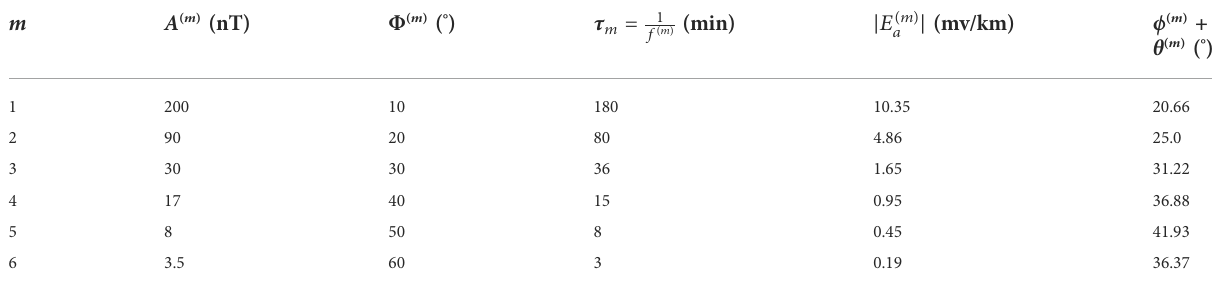
TABLE 4 Parameters of synthetic magnetic fi eld variation and analytic electric fi eld solution.